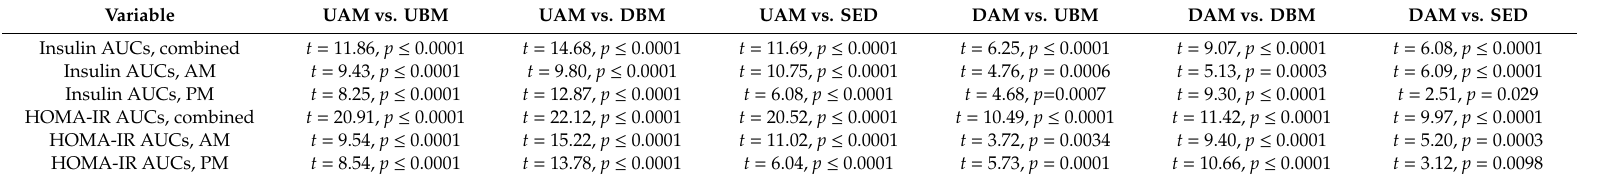
Table 4. Statistical di ff erences for insulin and HOMA-IR AUC group di ff